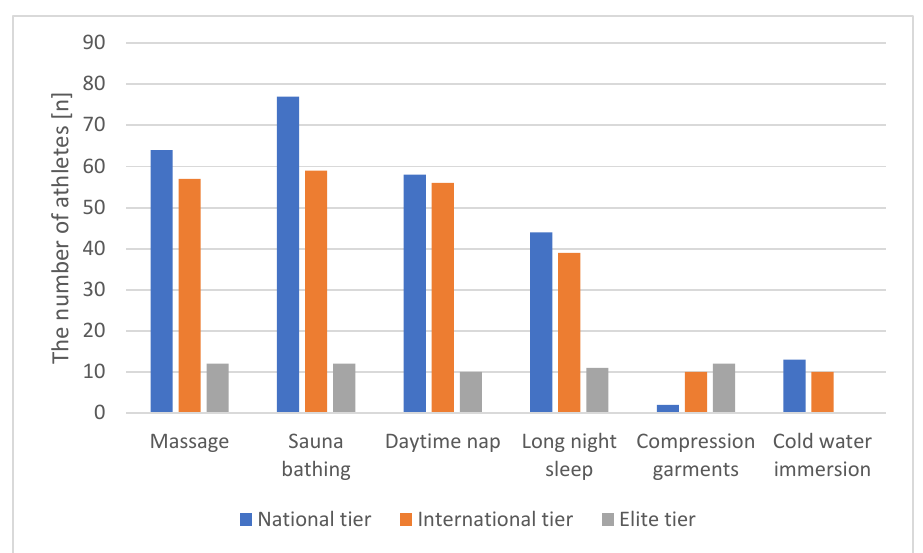
Figure 2. The use of recovery technique according to athletes’ discipline.